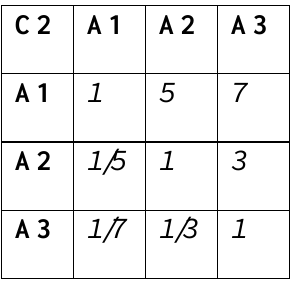
Table 4.4 Matrix M3: comparison of alternatives by the ratio of preference with respect to the criterion 2